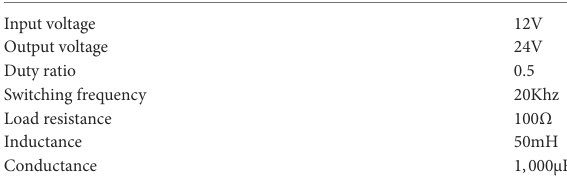
TABLE 1 Initial